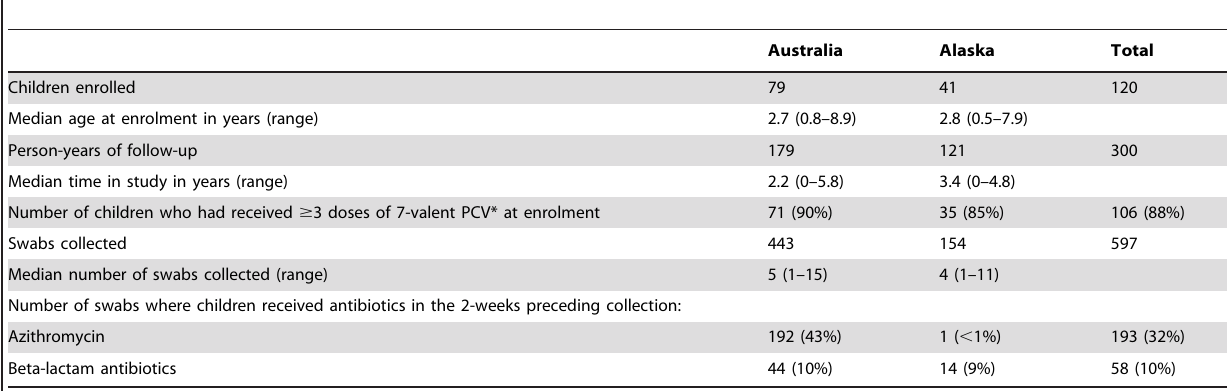
Table 1. Enrolment, swab collection, vaccination and antibiotic use in Australian Indigenous and Alaska Native